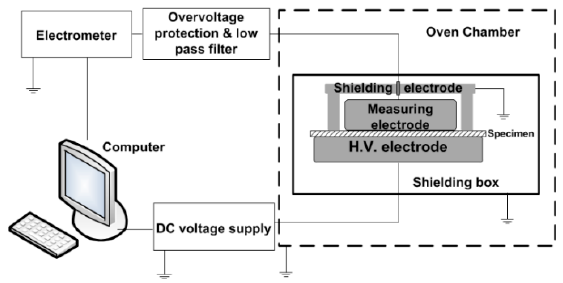
Figure 2. Schematic view of DC conductivity measurement